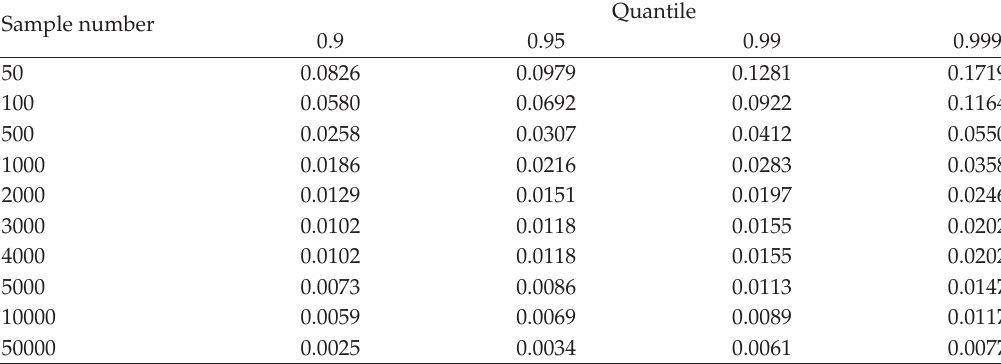
Table 1: KS test table for power-law distribution. The table was created assuming MLE as the estimation method.